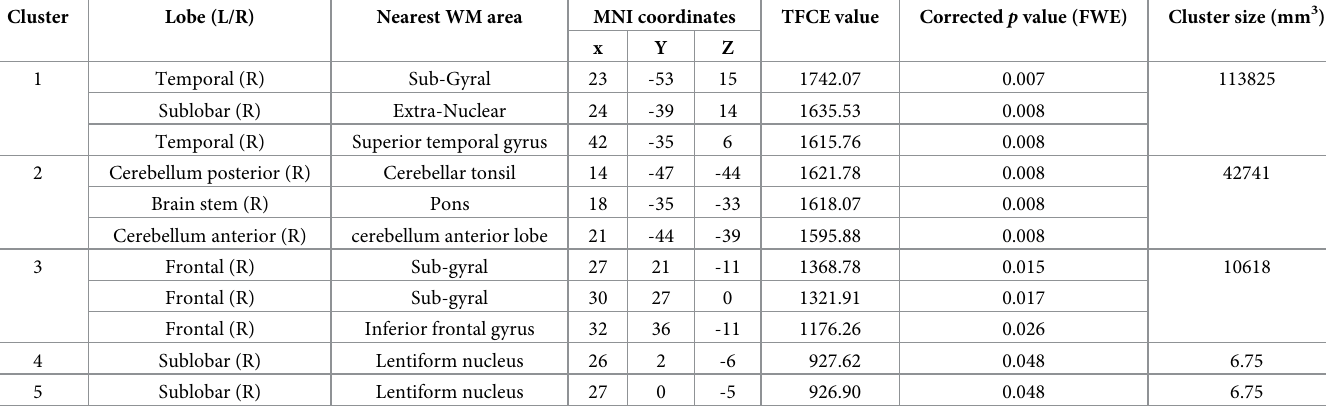
Table 4. Brain white matter regions with a significant negative main effect of IAT score on volume.